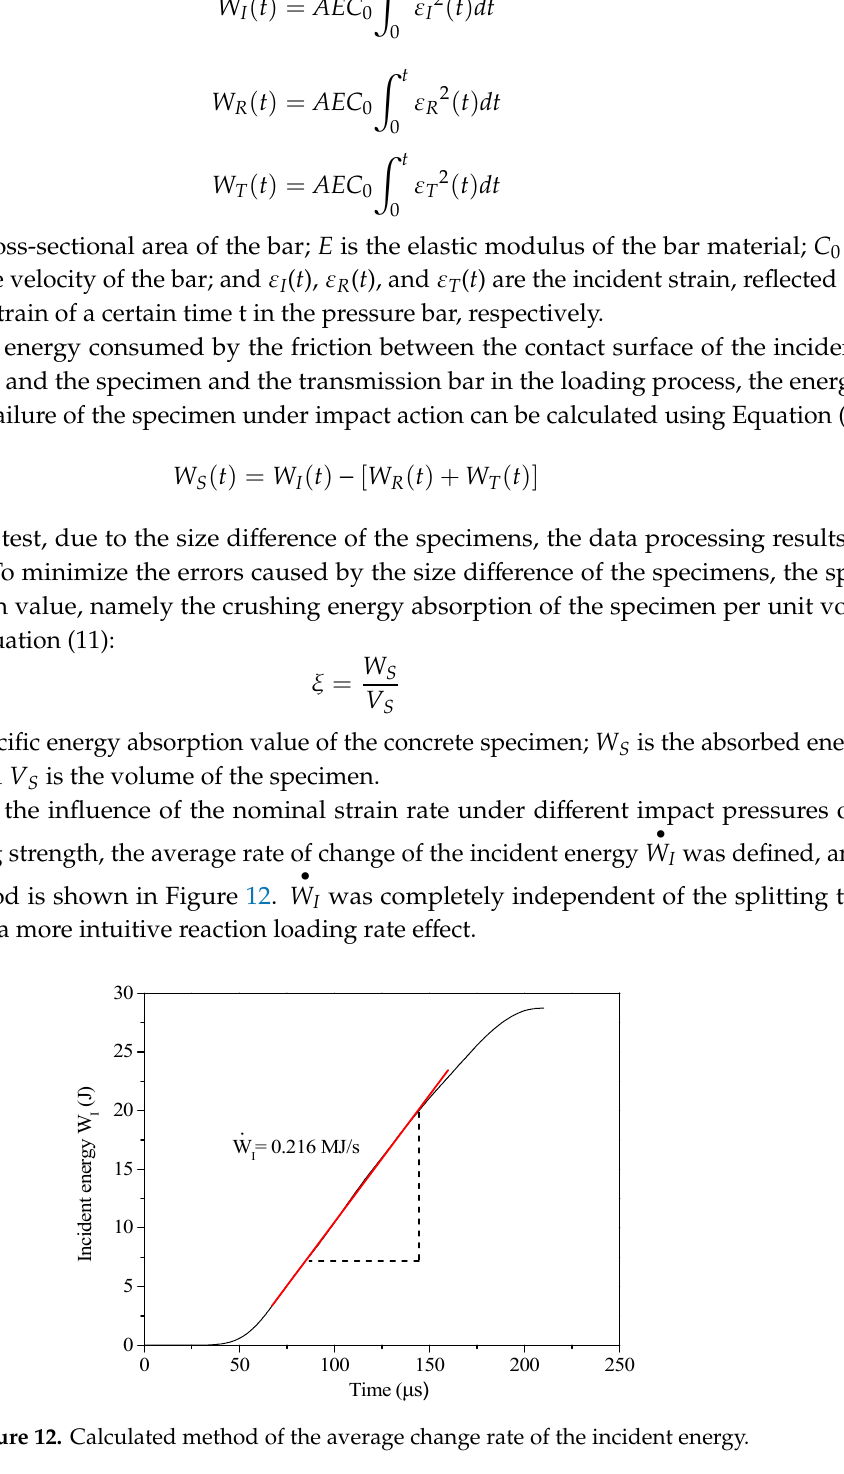
Table 4. Energy results of the SHPB test of concrete at different temperatures.